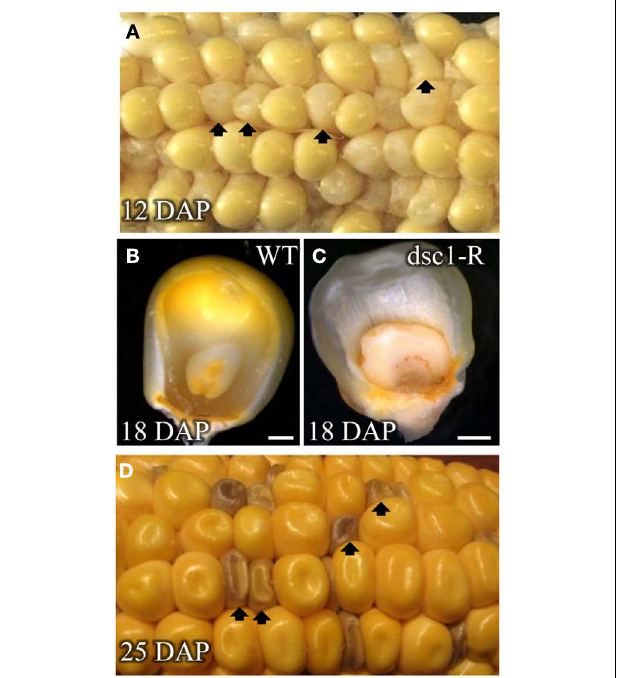
FIGURE 1 | dscl-R is a defective kernel mutation. Self-pollinated ear of a Dscl/dscl-R heterozygous plant harvested at (A) 12 DAP segregating dscl-R mutant kernels. Frontal view of (B) non-mutant sibling and (C) dscl-R mutant kernels harvested at 18 DARThe outer layer is removed to reveal the embryo and endosperm inside of the pericarp. (D) Ear harvested at 25 DAP segregating dscl-R mutant kernels. Arrows denote dscl-R mutant kernels. DAP, days after pollination. Scale bars represent